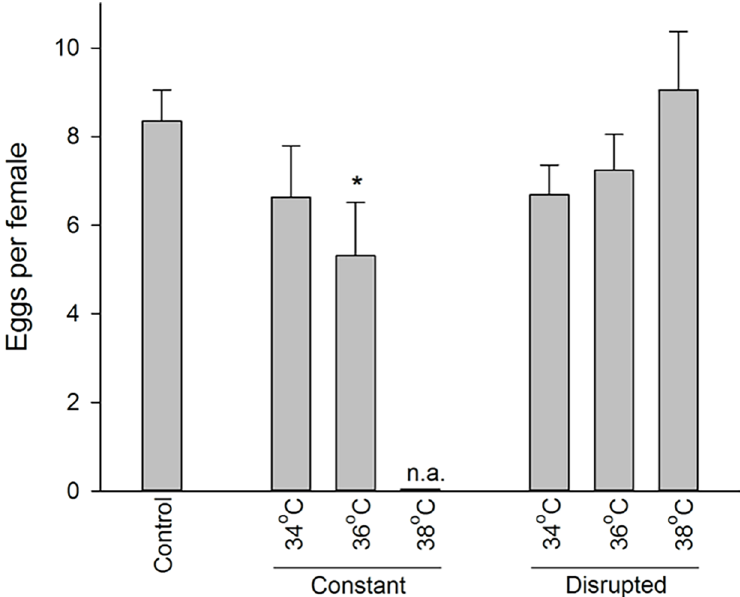
Fig 4. Egg production of Cimex lectularius after heat stress. Egg production in Cimex lectularius populations (mean number of eggs per female) after 7 weeks of the constant and disrupted heat treatments per female. Data from the 2 and 3 week treatments are pooled. (cid:3) denotes significant difference relative to control (Dunnett’s method, p < 0.05).